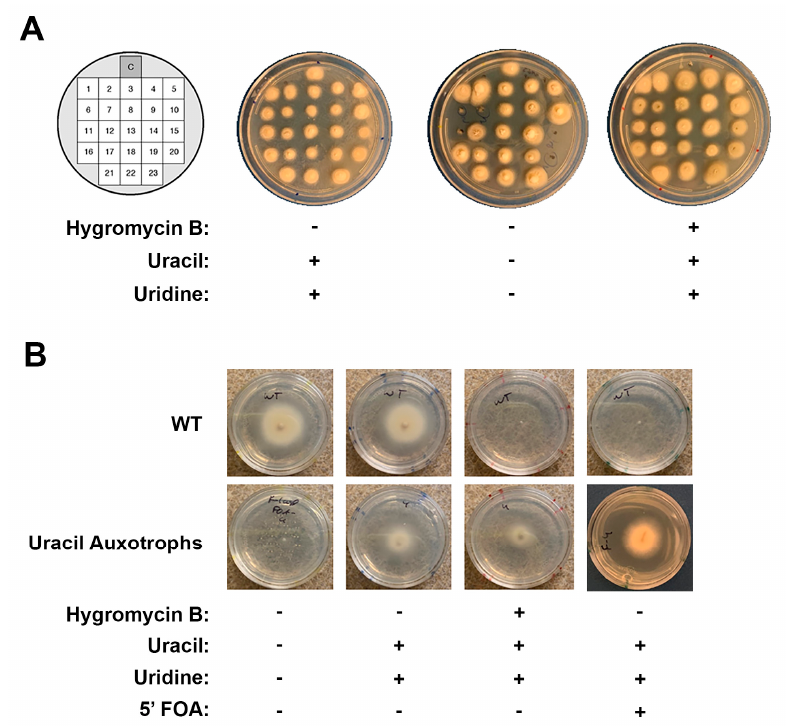
Figure 2. Phenotyping transformants for uracil auxotrophy and 5-FOA resistance. ( A ) Transformants were picked and replicated across three growth conditions with each position on the plate corresponding to a single transformant. The topmost position is the wild-type control. Transformants in positions 6, 7, 11, 15 and 20 displayed the desired uracil auxotrophy phenotype (center plate). ( B ) A subculture of an uracil auxotroph as compared to the wild type control. Incubation times varied from 5–10 days at 30 °C. Incubation on Media containing 5-FOA needed 10 days for comparable growth to media without 5-FOA.